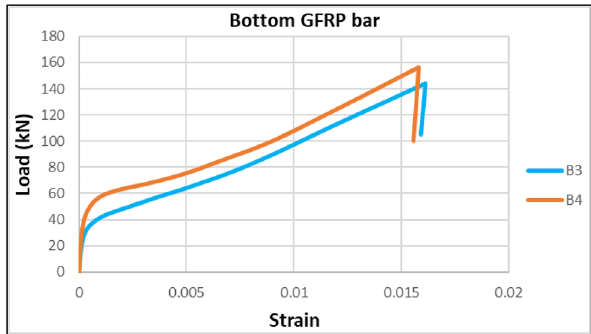
Figure 11: Strain of the bottom bar for specimens beams B3 and B4.